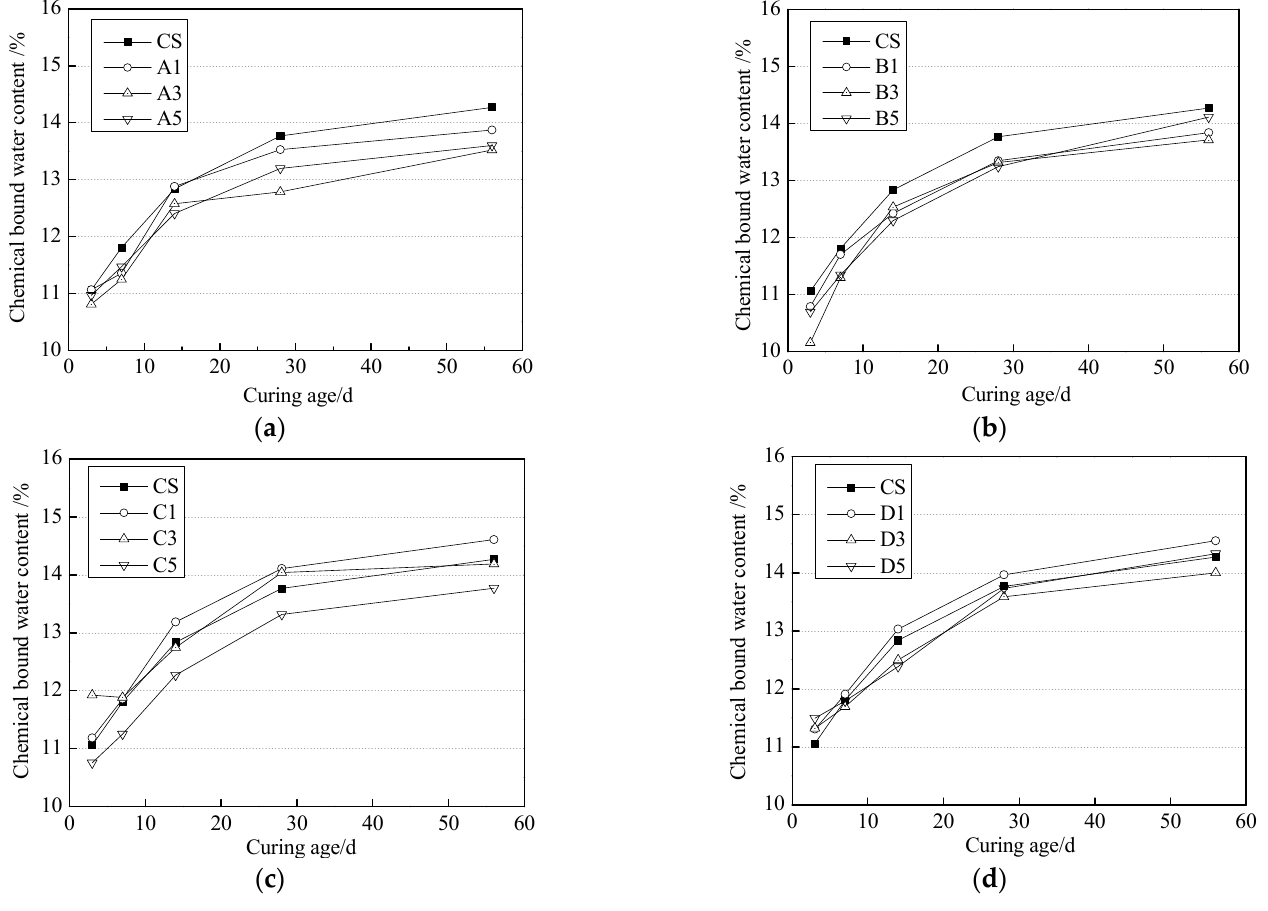
Figure 8. Chemical-binding water content of cement with NAC under 650 °C calcination. ( a ) Raw ore; ( b ) High-viscosity ore; ( c ) Raw ore under 650 °C calcined; ( d ) High-viscosity ore under 650 °C calcined.